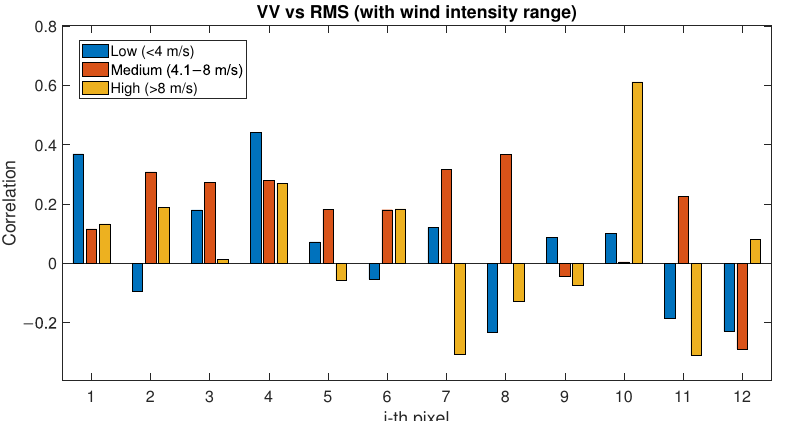
Figure 16. Correlation factor between SAR (VV polarisation) and RMSH evaluated for low-, medium- and high-wind-speed